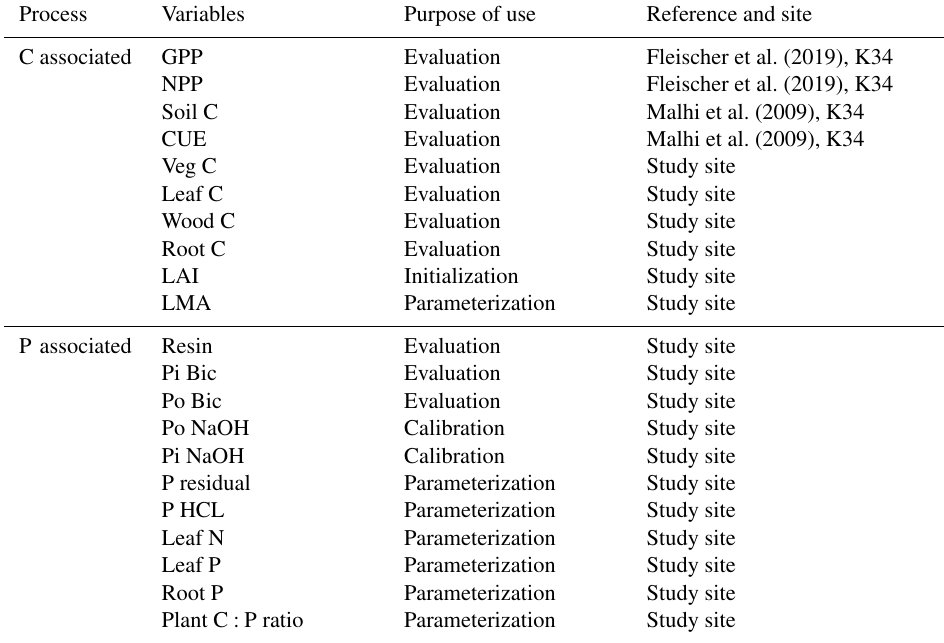
Table 4. Observations from the study site (taken during 2017–2018) and from the Manaus site K34 used for model parameterization and evaluation.